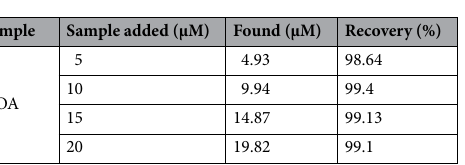
Figure 10. ( A ) DPVs got for different of concentration 1–6 µM DOA in PBS (pH 7.4) with AA (1 mM), UA (1 µM) and FA (10 µM) at Po-RD/Al-ZnO MCPE. ( B ) DPVs got for different of concentration 1–6 µM UA in PBS (pH 7.4) with AA (1 mM), DOA (1 µM) and FA (10 µM) at Po-RD/Al-ZnO MCPE.